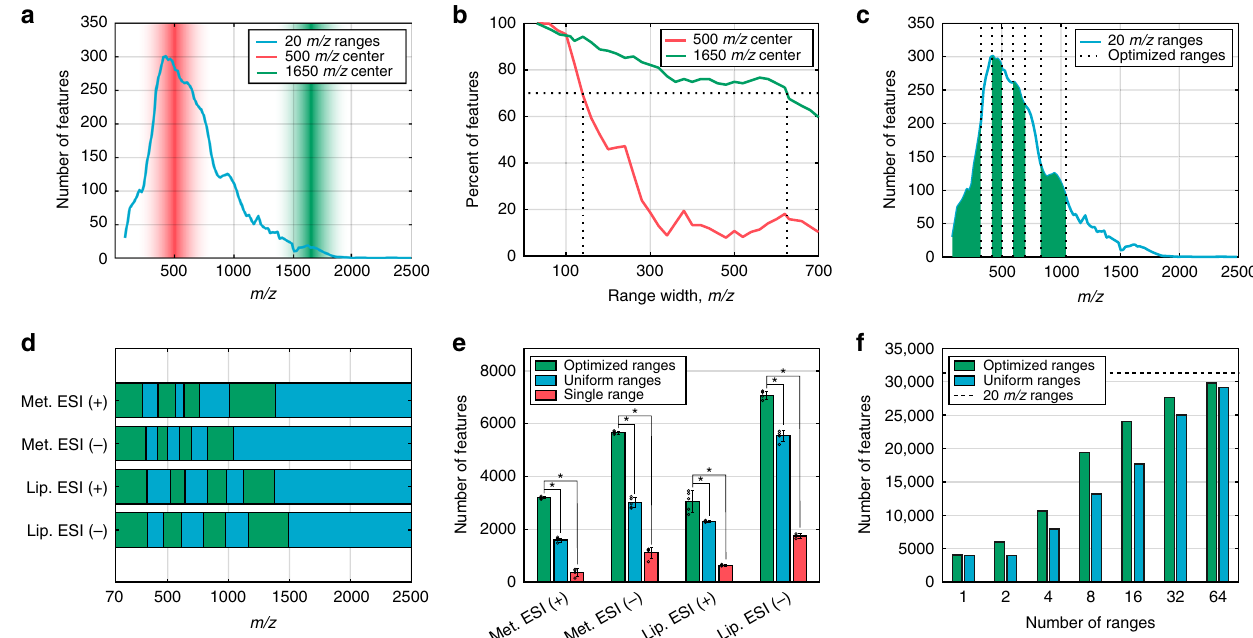
Fig. 2 Optimizing the sensitivity of rapid fl ow-injection mass spectrometry via nonuniform scan ranges. a An experimental scheme for investigating the effect of scan range width on the number of reproducibly detected m/z features: FI-MS analysis of metabolite extracts from serum samples is performed with a series of scan ranges with increasing sizes around a point of 500 m/z (where the mass-stitching revealed numerous reproducible features; in red) and a point of 1650 m/z (where a small number of features are observed; in green). Speci fi cally, using a series of ranges of size 40 – 700 m/z , in steps of 40 m/z units. b The percent of reproducible m/z features identi fi ed around the points of 500 (in red) and 1650 m/z (in green), as a function of the scan range width (out of the total number of features with the minimal 40 m/z scan range). c The distribution of the number of reproducible features found for metabolomics analysis of serum samples by FI-MS in negative mode; and the optimized eight scan ranges represented by vertical lines. d The optimized scan ranges for metabolomics and lipidomics FI-MS-based analysis of serum samples in positive and negative ionization modes. e The number of reproducible m/z features identi fi ed with the optimized eight scan ranges (in green), eight uniform scan ranges (in blue), and using a single scan range (in red). * p < 0.004 by two-sample two-sided t -test. Data are mean ± SD, n = 5 independent repetitions of the FI-MS analysis. f The total number of reproducible m/z features ( y axis; metabolomics and lipidomics analysis via positive and negative ionization modes) identi fi ed when scanning using optimized scan ranges (in green) versus when using uniform width scan ranges (in blue), considering different numbers of scan ranges ( x axis); the black horizontal line marks the number of reproducible features observed when scanning using the exhaustive 20 m/z scan ranges. Source data are provided as a Source data fi